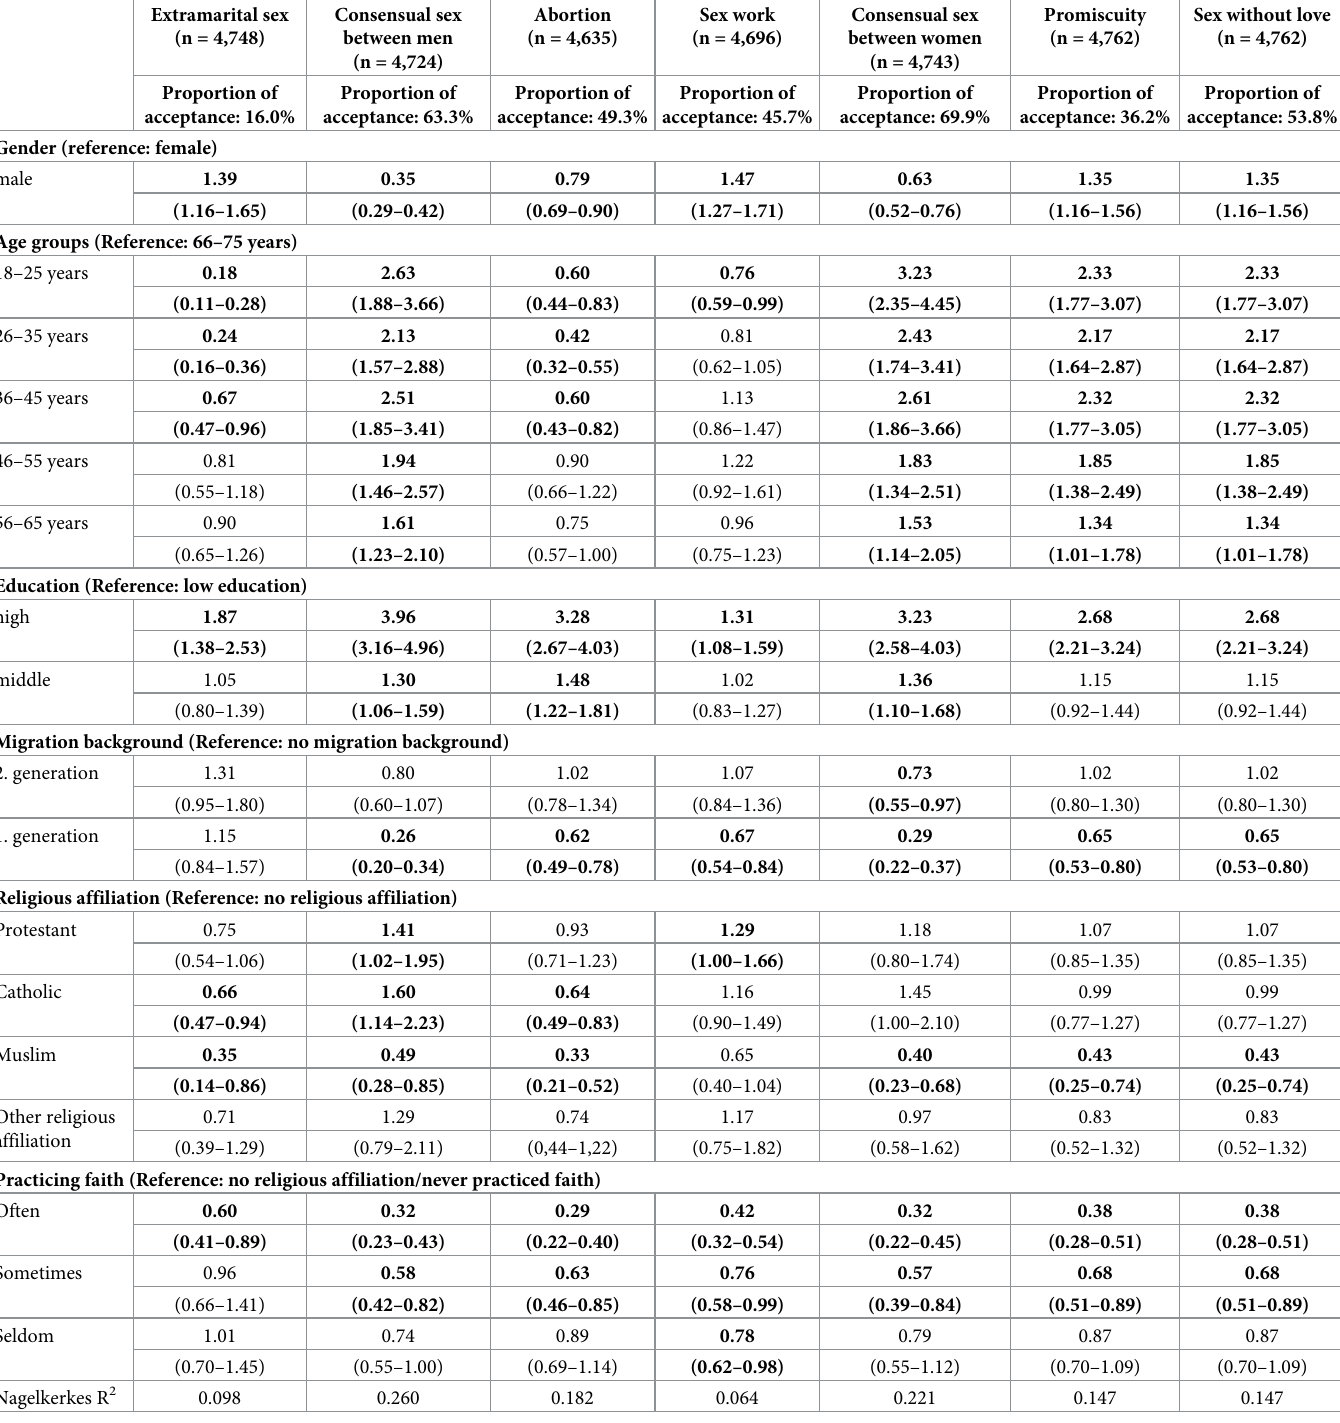
Table 3. Associations between sociodemographic, sociocultural factors and acceptance towards sexual behavior � : Odds Ratios (OR) and 95% confidence intervals (CI) (weighted data): German Health and Sexuality Survey